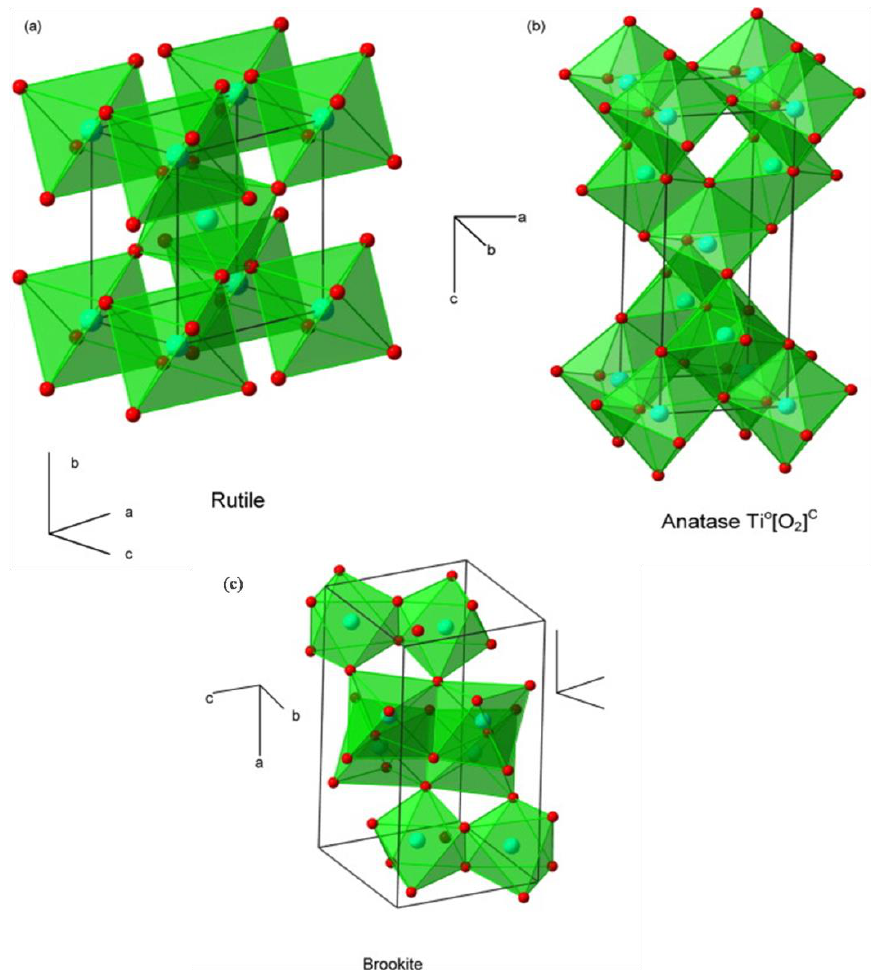
Figure 1. Building-block representation of TiO 2 ( a ) rutile phase, ( b ) anatase phase, and ( c ) brookite phase. Reprinted with permission from [11], Copyright 2009, Elsevier.